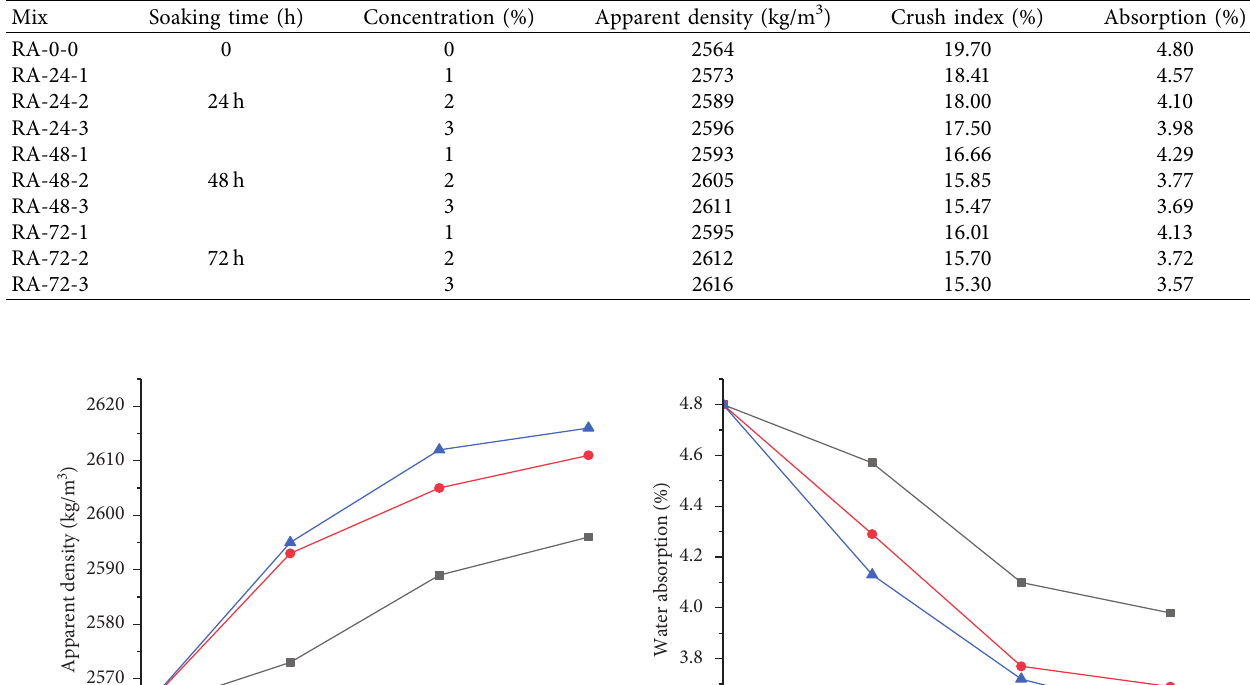
Table 2: Physical performance of the nanosilica-modified RA.